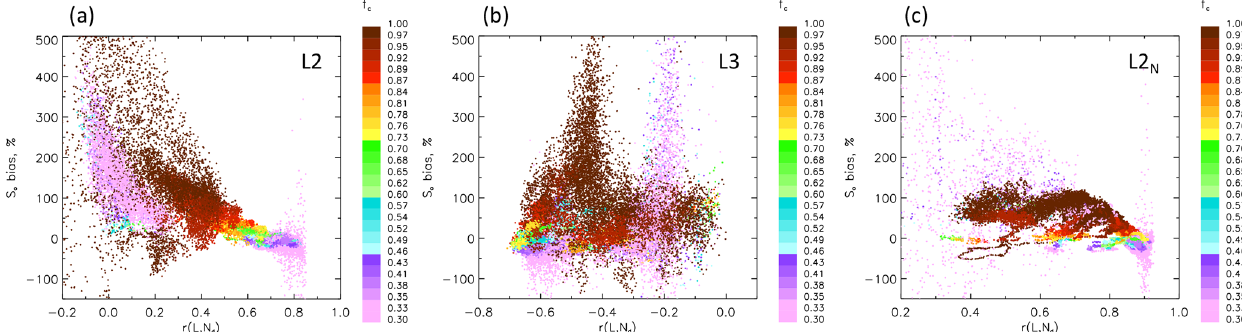
Figure 4. S o bias in percent as defined in Eq. (12) as a function of the correlation between liquid water path and drop concentration r ( L , N d ) with points colored by cloud fraction f c for the (a) L2, (b) L3, and (c) L2 N methodologies. In (a) and (c) the S o bias tends to increase with decreasing r ( L , N d ) and increasing cloud fraction f c , with noted exceptions. Use of the true N d in (c) restricts the S o bias to about